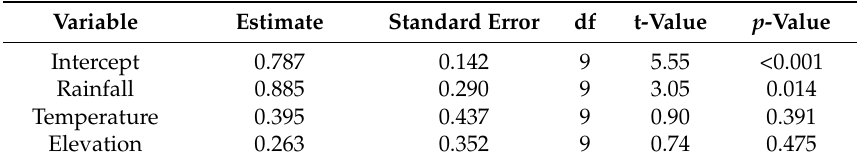
Table 1. Estimates of the mixed effect model of NRI and the three abiotic variables rainfall, elevation, and temperature. The random variable “Sites” was not considered within the model, and variability was insignificant (standard deviation = 2.30e −05 ).